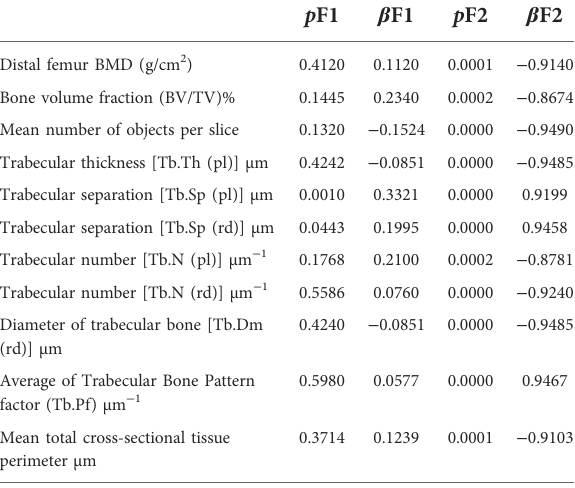
TABLE 5 Expression information of key proteins HDAC8, LRTOMT, TGS1 and ANKRD46.